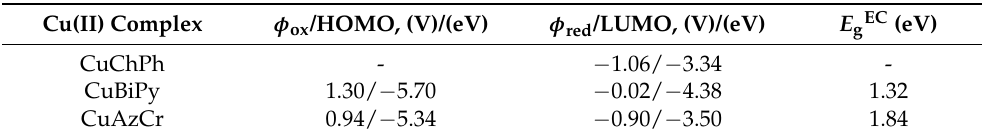
Table 1. Data obtained by cyclic voltammetry, C complex = 10 − 3 M in CH 3 CN, glassy carbon